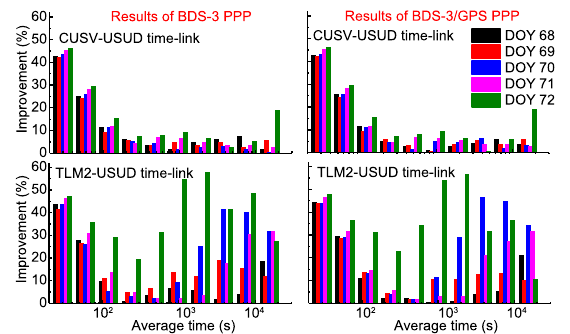
Fig. 16 The improvement of BDS-3 or BDS-3/GPS PPP with Scheme 2 with respect to that of Scheme 1 for two time-links (CUSV-USUD and